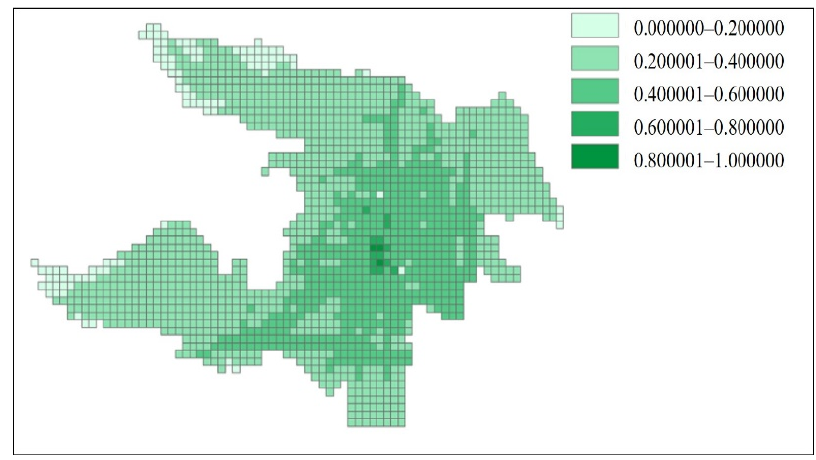
Figure 8. Visualization of the relative external accessibility of Zhicheng.